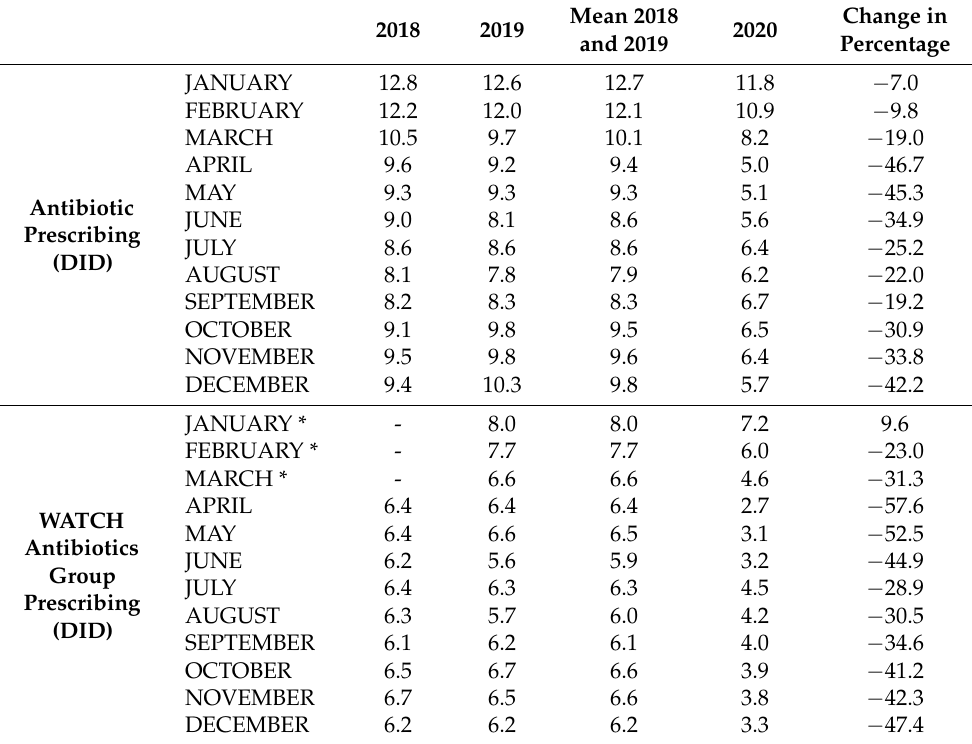
Table 1. Monthly comparison analysis of antibiotics prescribing in outpatient care, before and after COVID-19 appearance.